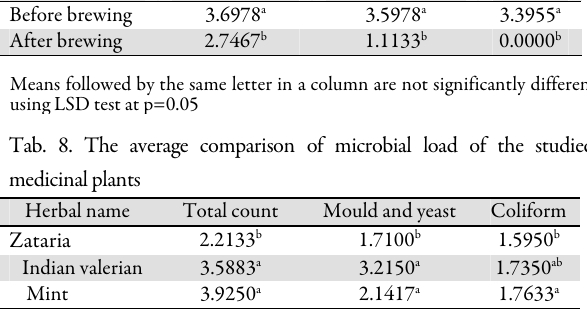
Tab. 7. Mean comparison of microbial load in before and after brewing Treatment